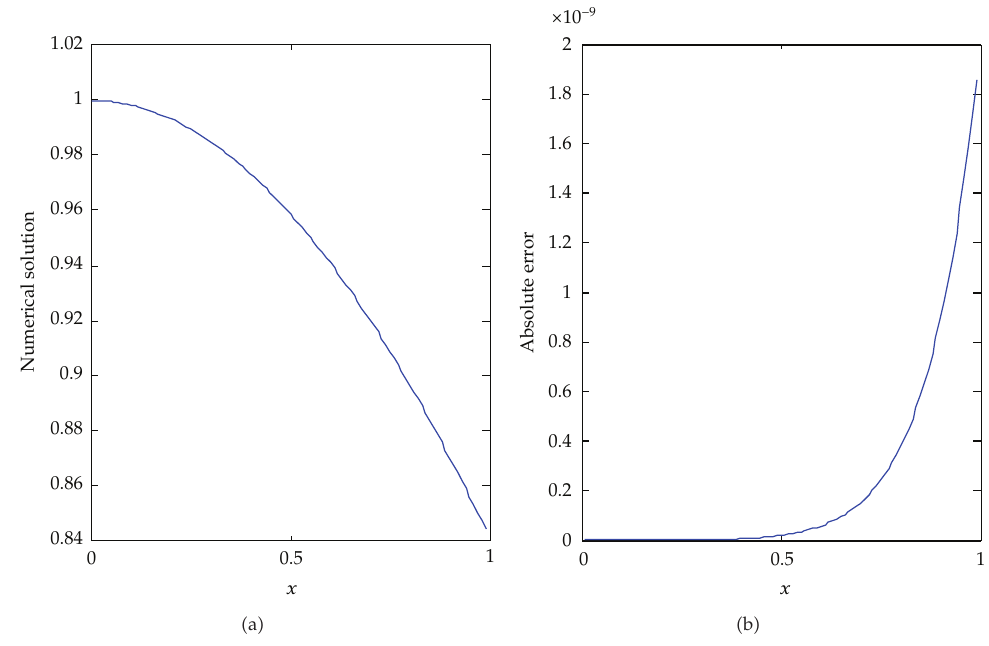
Figure 2: Numerical solution and absolute error of Example 4.2 when n (cid:7) 1.